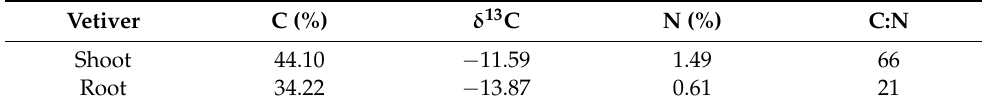
Table 7. Properties of above- and below-ground biomass of vetiver grass.